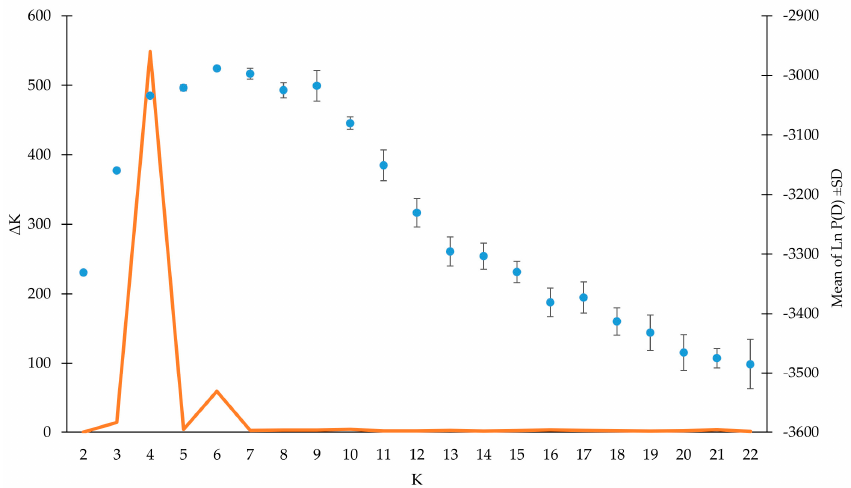
Figure 3. Definition of the number of ancestral corn populations based on the SSR marker dataset. Mean LnP(D) ± SD over 10 runs is a function of K, as L ′ (K) = Δ LnP(D). Mean Δ K is calculated as ∣ L ′′ (K) ∣ /(SD(L(K)) following Evanno et al. [35]. Δ K values are represented by the orange line, while the blue points indicate the mean LnP(D) ± SD values.